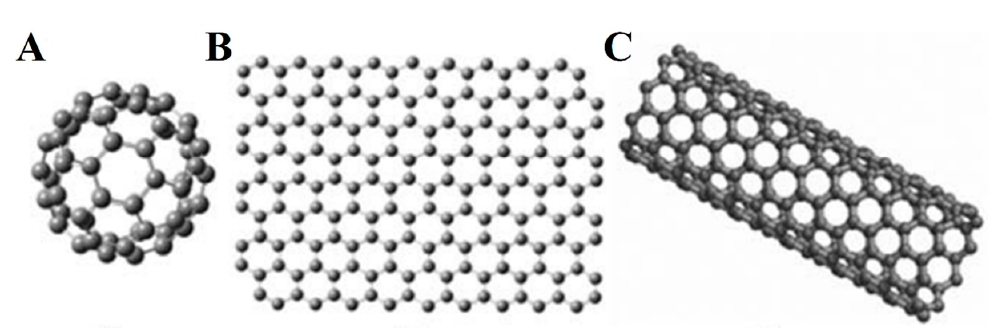
Figure 2. Three different geometrical structures of graphene (GR): ( A ) ball-shaped GR; ( B ) a GR sheet; and ( C ) carbon nanotubes (CNTs). Reproduced [22] with permission from Wiley-VCH, 2016.